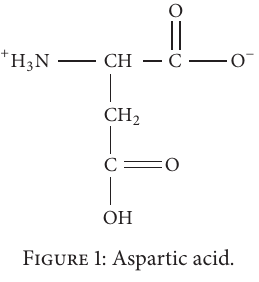
Figure 1: Aspartic acid.